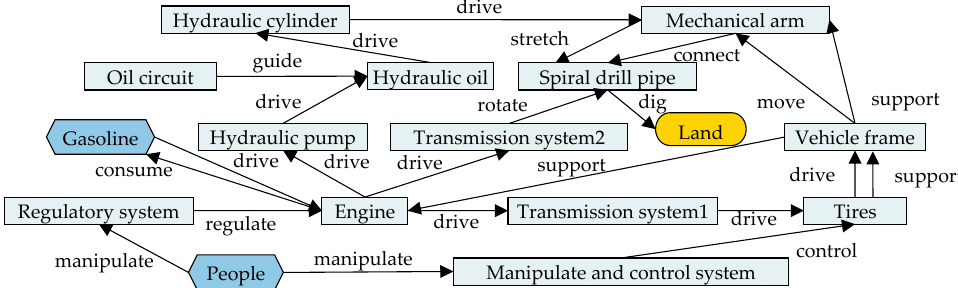
Figure 23. Functional structure of the drill pole tree-planting machine.